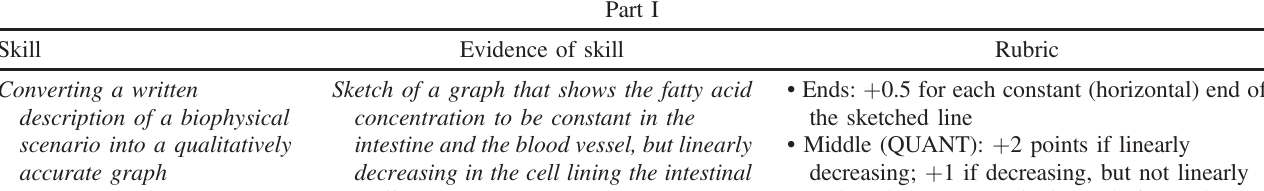
TABLE II. The emergent code and scoring rubric for analyzing the biology capstone diffusion task. IPLS 1-specific elements of the code are designated IPLS 1, and general quantitative skill elements are designated QUANT. The first column describes the relevant skill, the middle column the evidence that a response demonstrates that skill, and the final column presents the scoring rubric. Part I Skill Evidence of skill